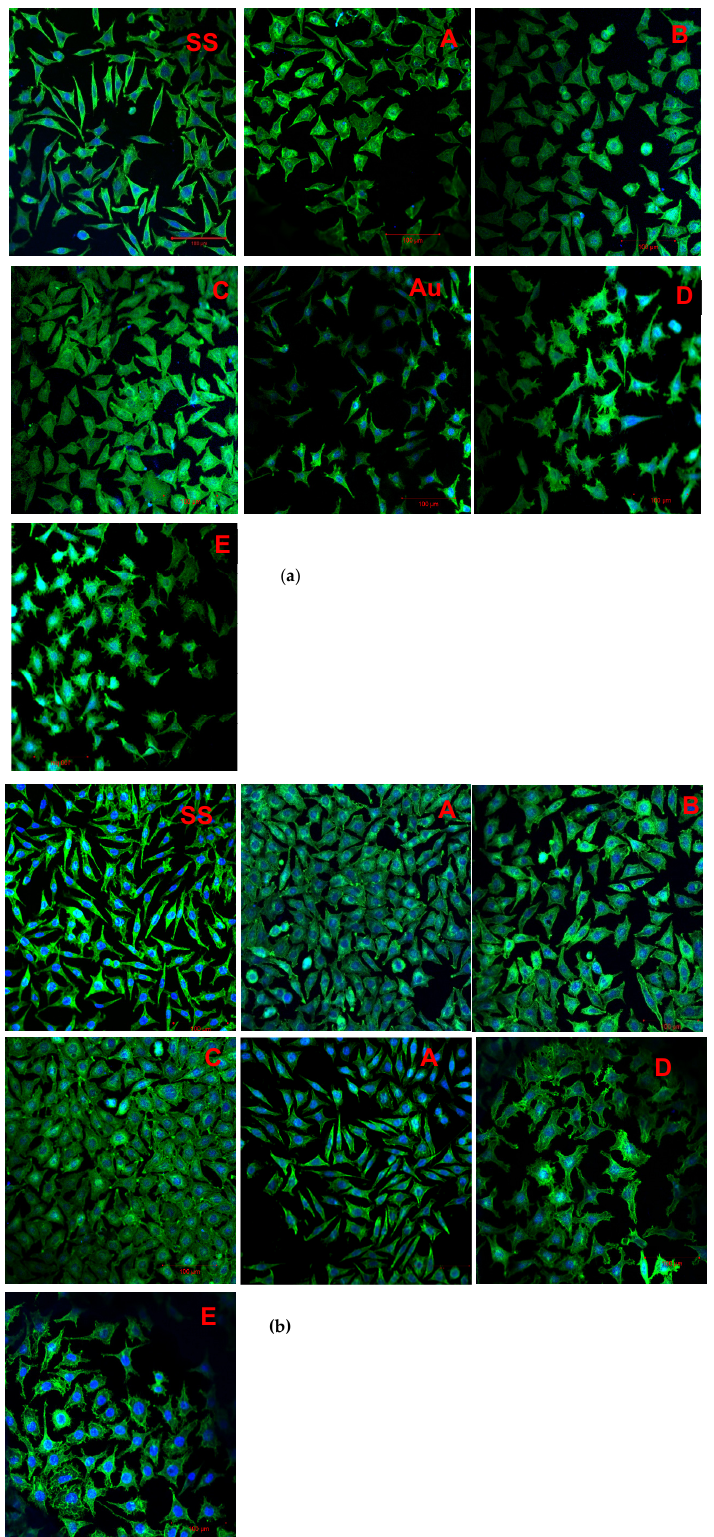
Figure 6. Cell adhesion on obtained materials after ( a ) 24 h and ( b ) 48 h of incubation with cells (variants are shown in red in the upper-right corner).